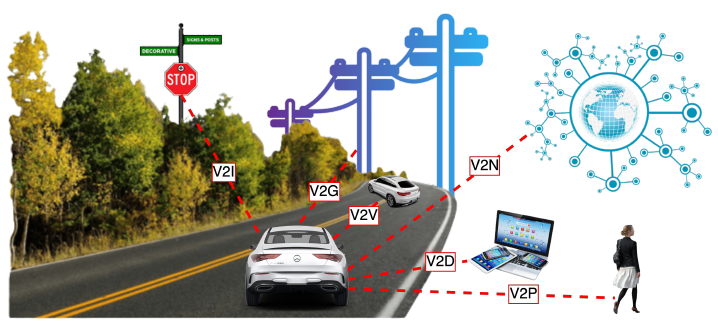
Figure 3. Concept diagram for Vehicle-to-Everything (V2X)